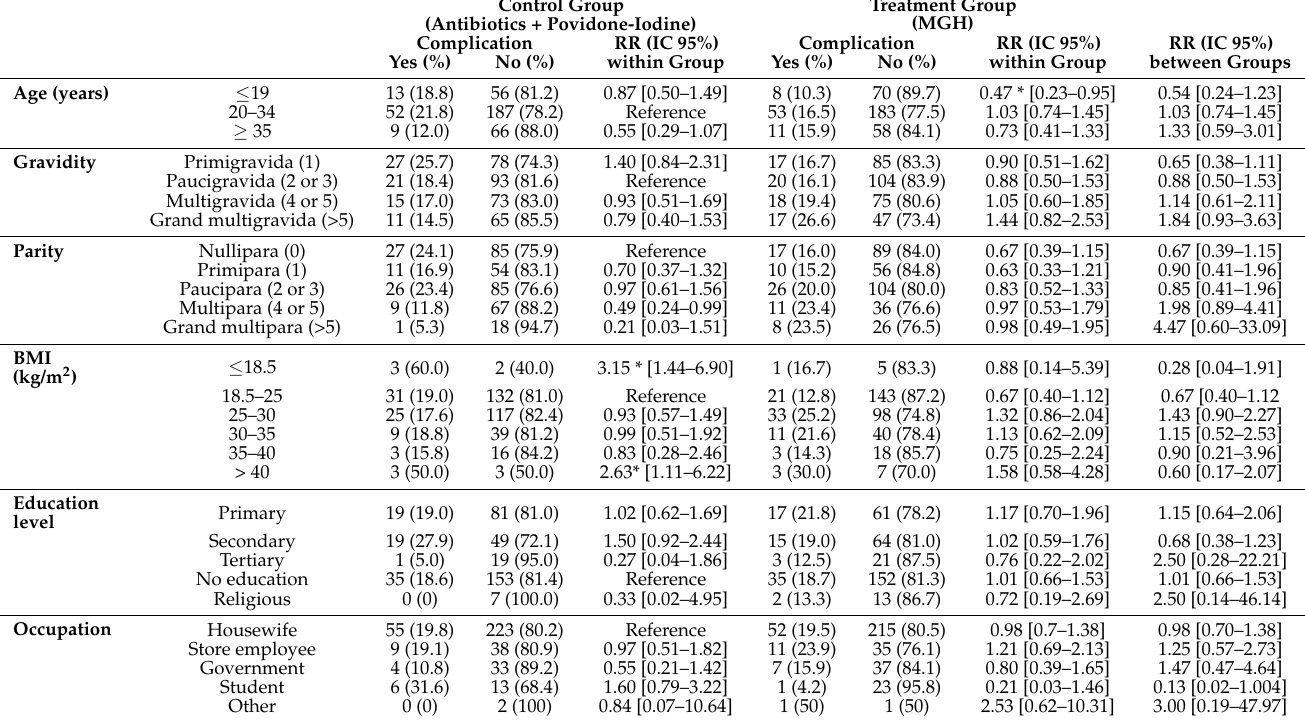
Table 5. The distribution of complications over different baseline characteristics per study group. Both the control and treatment groups consisted of 383 patients, with 74 and 72 patients considered to have postoperative complications, respectively. Subgroups were based on the presence or absence of postoperative complications. * represents a significant difference ( p < 0.05).